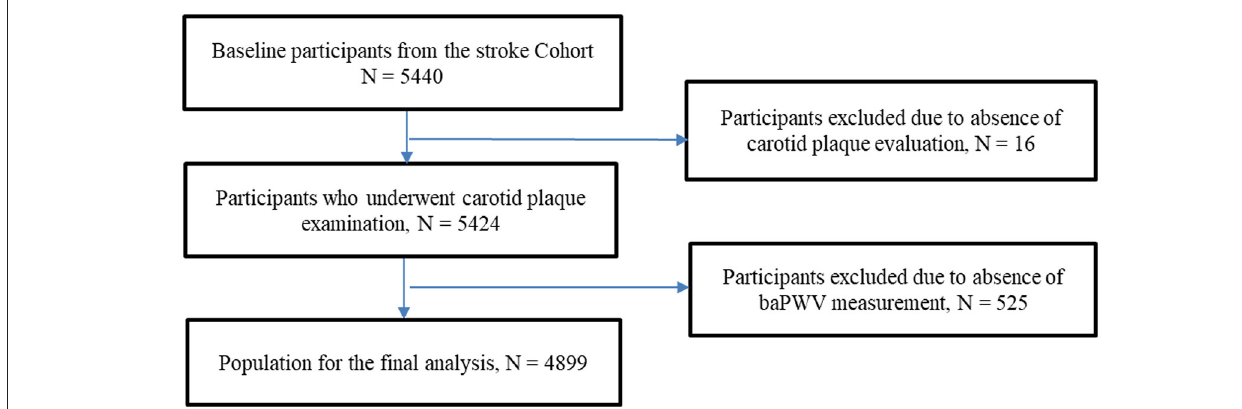
FIGURE 1 | Flow chart showing enrolment of the study participants.